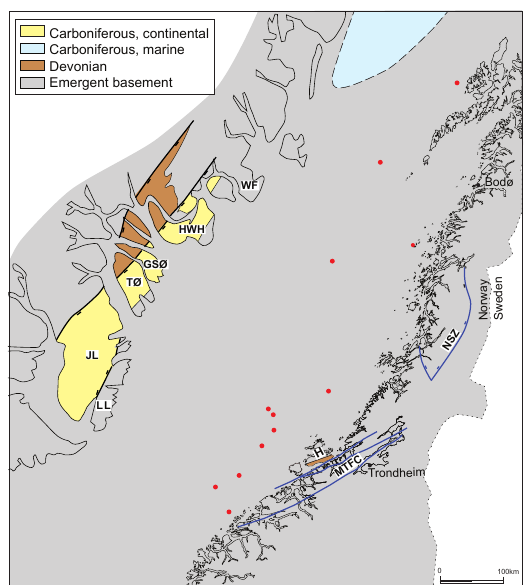
Figure 7. Carboniferous paleogeography. The area between Norway and East Greenland is inter- preted as an emergent land mass. Carboniferous sediments deposited onshore East Greenland are entirely continental. Carboniferous rifting propagated from the north and Carboniferous marine sediments might have been deposited in the northeastern part of the region. No wells (red dots) drilled to basement offshore Lofoten–Vest - erålen and farther to the south have encountered Carboniferous sediments. Abbreviations: GSØ – Geographical Society Ø, H – Hitra island, HWH – Hold With Hope, JL – Jameson Land, LL –